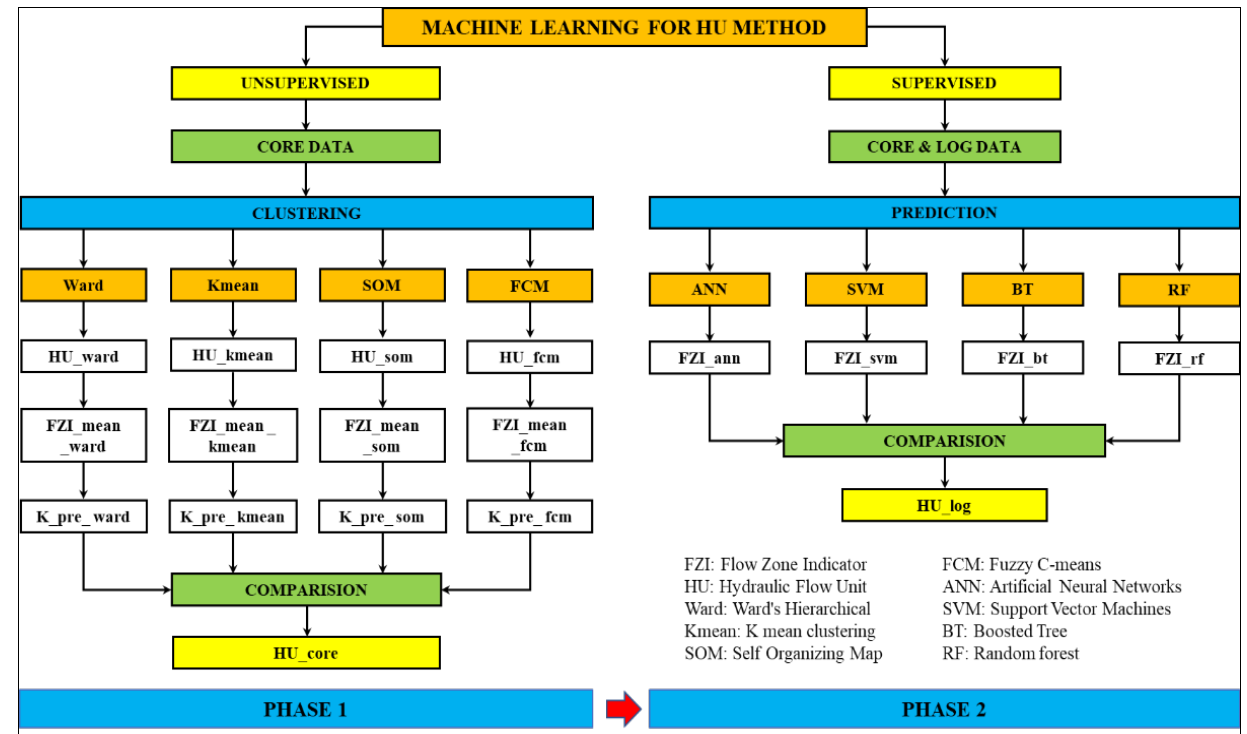
Figure 3. The workflow for applying machine learning for Hydraulic flow unit classification and prediction in this study. On the left side, Phase 1 shows the process of applying unsupervised learning methods for HU clustering. We test four methods: Ward’s Hierarchical, K-mean, Ward’s Hierarchical, Fuzzy C-means (FCM), and Self-Organizing Map (SOM). On the right, Phase 2’s supervised learning algorithms include Support Vector Machines (SVM), Artificial Neural Networks (ANN), Random Forest (RF), and Boosted Tree (BT).